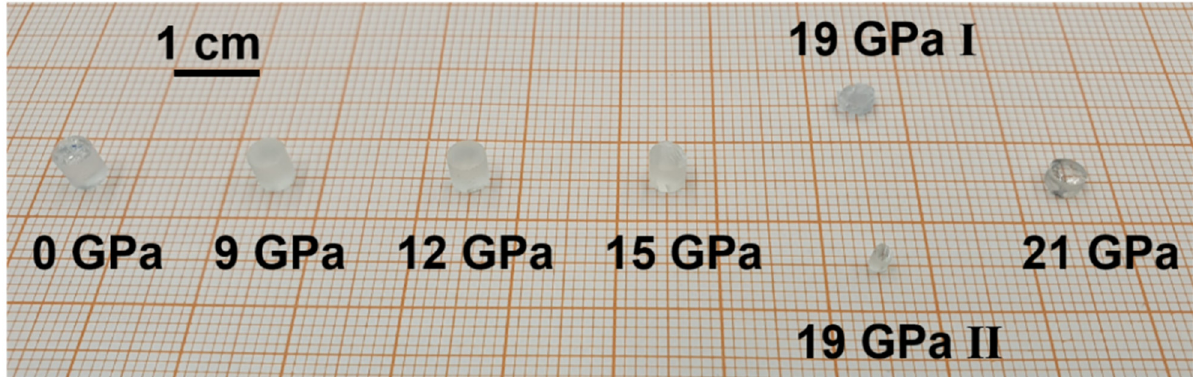
Figure 1. Overview of the series of permanently densified glass cylinders; densification was done at room temperature using a multi-anvil press (MAP) at maximum pressures of 9 GPa, 12 GPa, 15 GPa, 19 GPa and 21 GPa; preparation of the 19 GPa sample was repeated with a smaller glass cylinder (19 GPa II) as the original cylinder (19 GPa I) came into contact with MgO in the experimental setup.